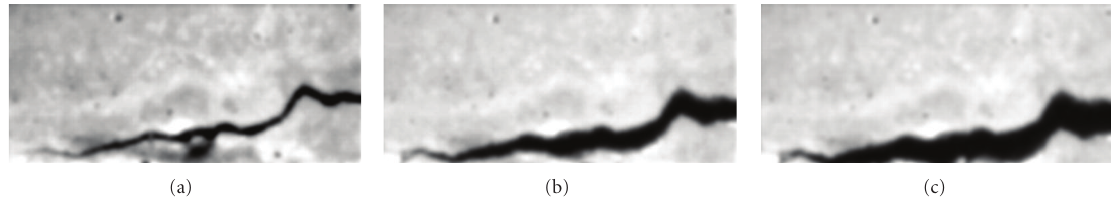
Figure 13: Cropped images (72 × 160 pixels) of concrete cracks at di ff erent times, from (a) to (c), denoted by T 1, T 2, and T 3. By synchronizing with the loading time, T 1 = 30 . 5 seconds, T 2 = 34 . 75 seconds, and T 3 = 39 . 75 seconds (these time stamps are di ff erent from the relative ones used in Figure 10.